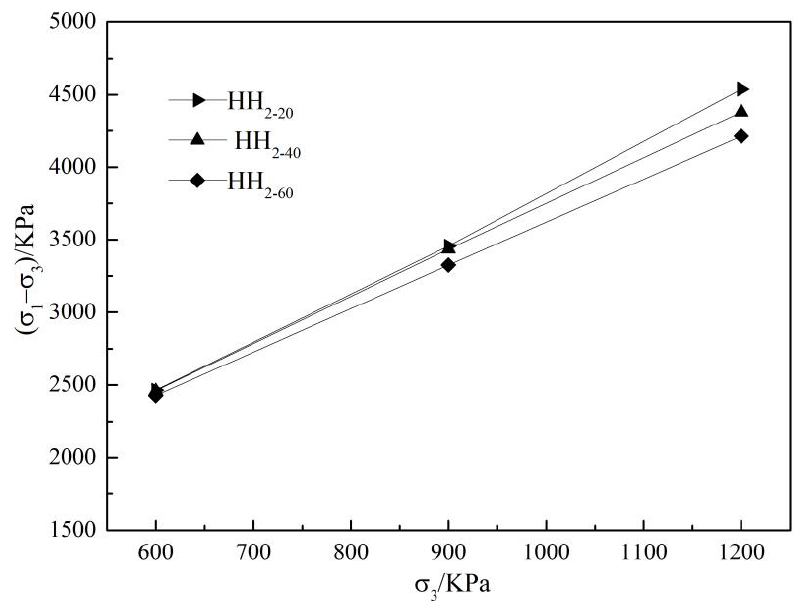
Figure 4. The relationship between peak strength and confining pressure.